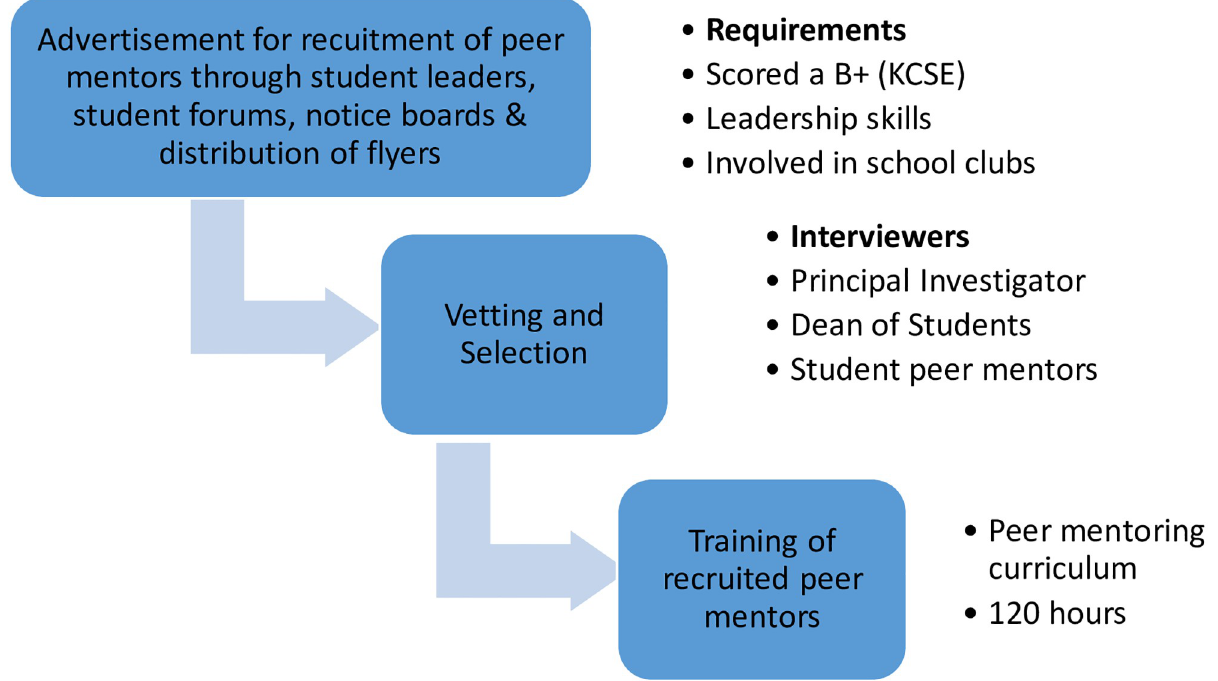
Fig 3. Flowchart of the recruitment